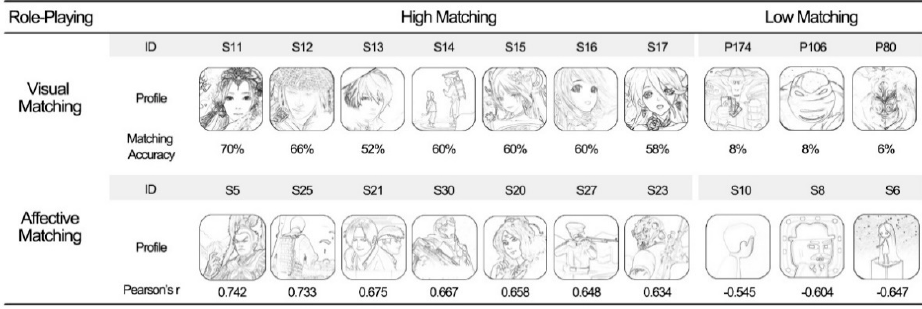
Figure 6. Role-playing game icons with high perceptual matching.